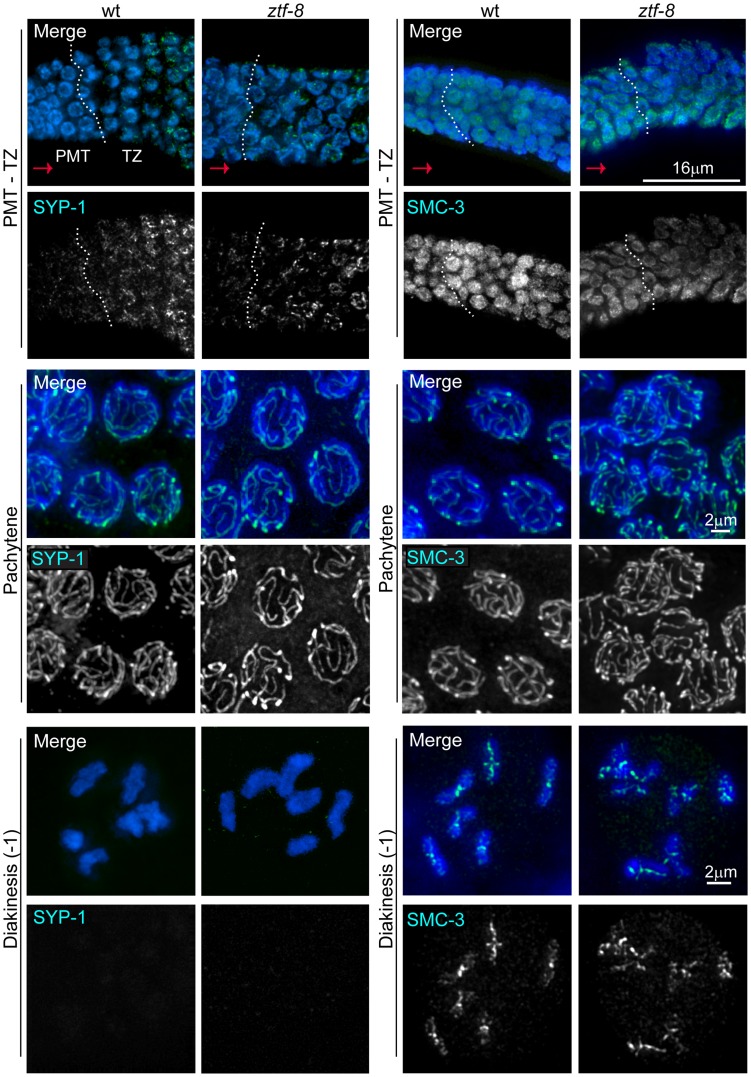
ZTF-8 is dispensable for axis morphogenesis and chromosome synapsis.Analysis of whole-mounted germlines from wild type and ztf-8 mutants co-stained with DAPI (blue) and either SYP-1 (green) or SMC-3 (green), reveals that axis morphogenesis, and chromosome synapsis, are indistinguishable from wild type. Images show premeiotic tip (PMT)/transition zone (TZ), pachytene, and diakinesis nuclei where chromosomes initiate synapsis, are fully synapsed, and undergo SC disassembly, respectively. Progression from PMT to TZ is observed from left to right, as indicated by the red arrows; dotted white vertical lines indicate the boundary between the PMT and TZ. As in wild type, SYP-1 signal is observed associated with chromosomes from transition zone through most of diakinesis and is no longer present in the last oocyte prior to the spermatheca (−1 oocyte) in the mutants (20/20 gonads). Immunolocalization of SMC-3 reveals normal axis morphogenesis throughout meiotic progression in ztf-8 mutants compared to wild type, with signal observed associated with chromosomes until the end of diakinesis (20/20 gonads).